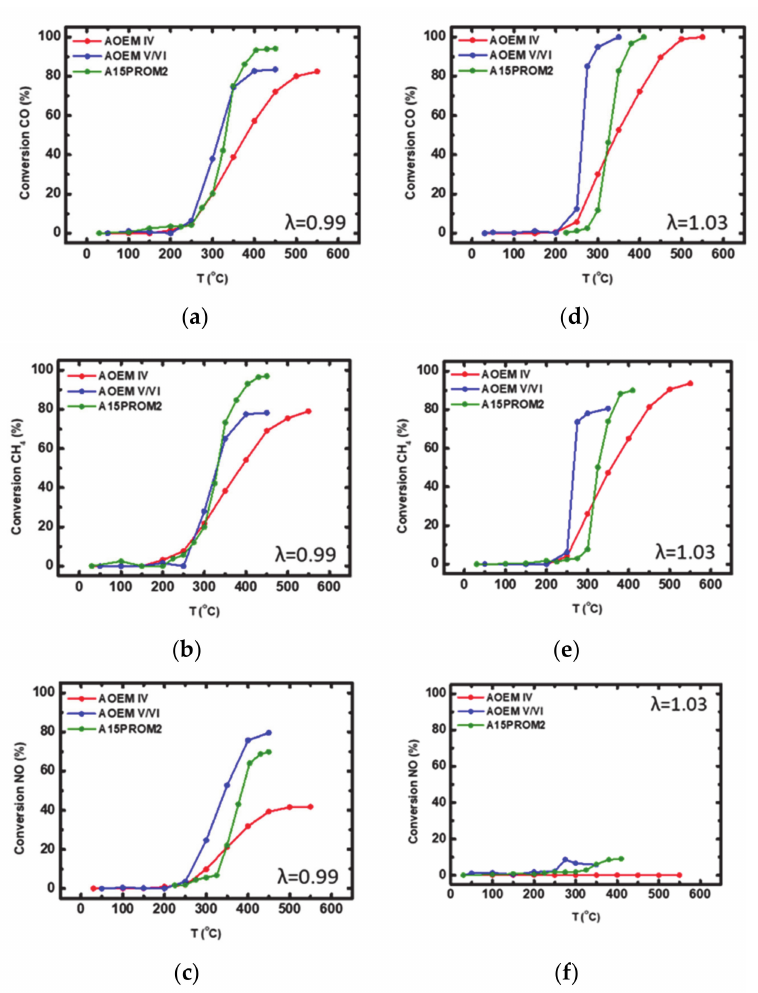
Figure 13. Light-off curves for the conversion (%) of: ( a ) CO; ( b ) CH 4 ; ( c ) NO under rich-burn